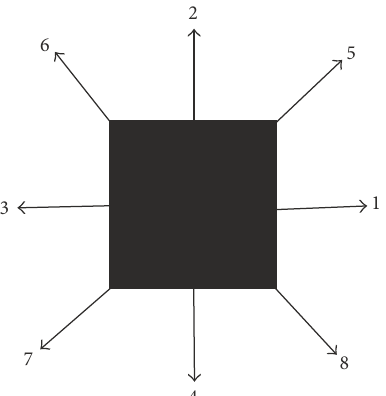
Figure 1: The eight growth directions of each point for 2D systems [17, 18].